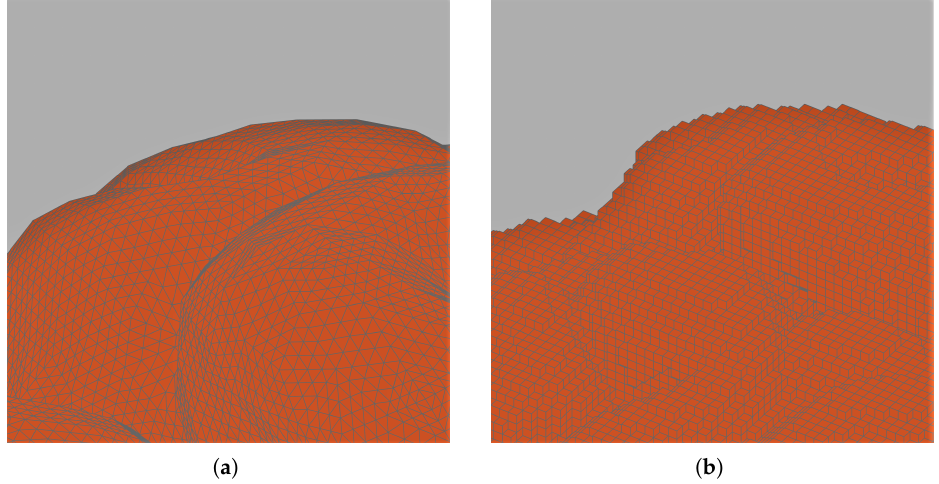
Figure 1. No stair-casing effect on curved boundaries thanks to tetrahedral discretization ( a ). Stair- casing effect on curved boundaries due to the use of a voxel-based mesh ( b